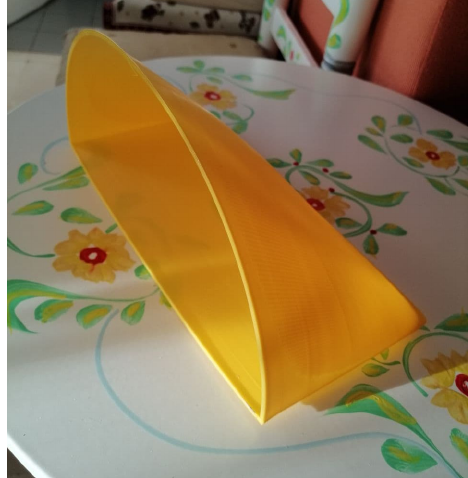
Figure 34. 3D print of a conoid similar to Doganoff’s skylight.